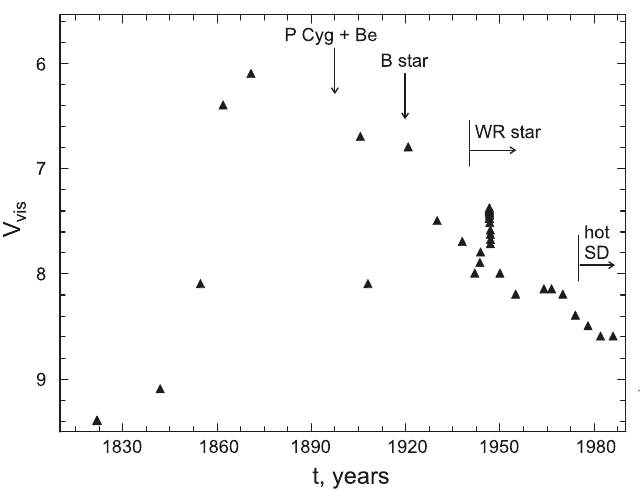
Fig. 1. Visual light curve of the symbiotic nova AG Peg in